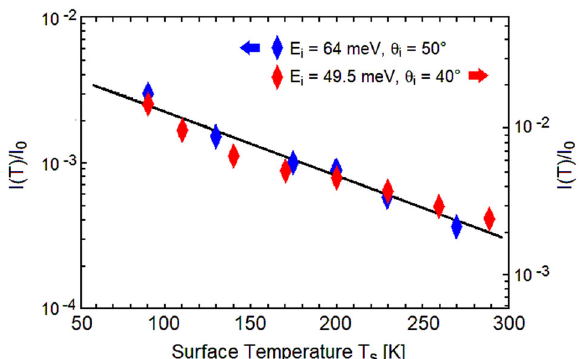
Fig. 4 E-ph coupling determination by the thermal attenuation of the He specular peak from PdTe 2 . Thermal attenuation of He- specular intensity of 1T-PdTe 2 measured along Γ M at two different incident energies E i and angles θ i . Note the shifted log scale for the two sets of data, so as to have a single average slope for all data and an average λ = 0.58 ±